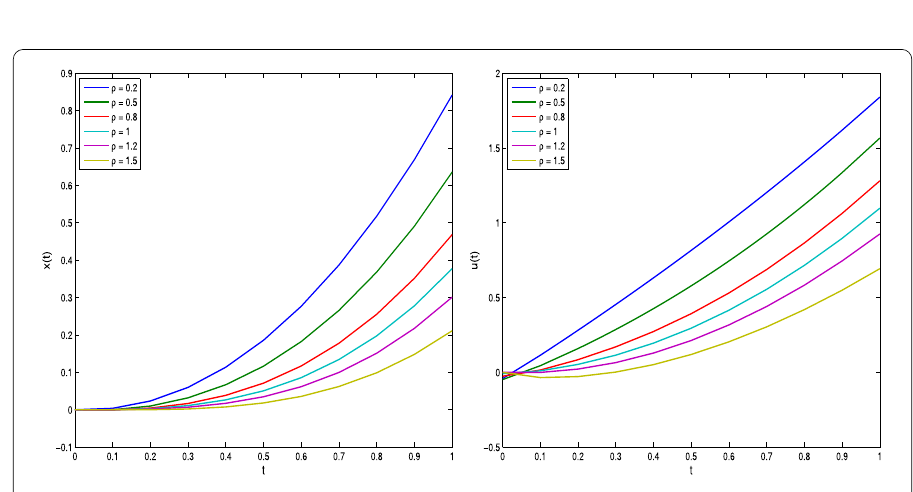
Figure 1 The approximate state x ( t ) (left) and the approximate control u ( t ) (right) at various values of ρ and α = 0.5, N = 3